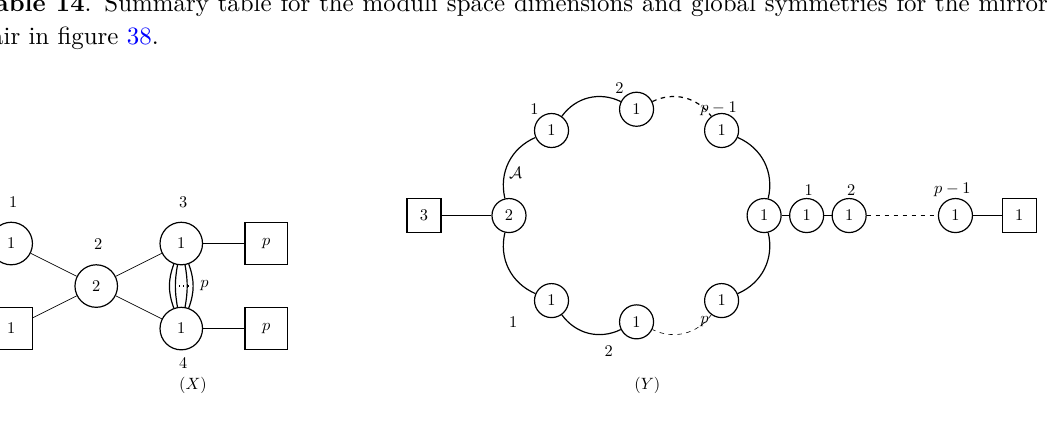
Figure 38 . An example of a Lagrangian realization of the dimensional reduction of a 4d SCFT which is constructed in the class S picture from an irregular puncture and a regular maximal